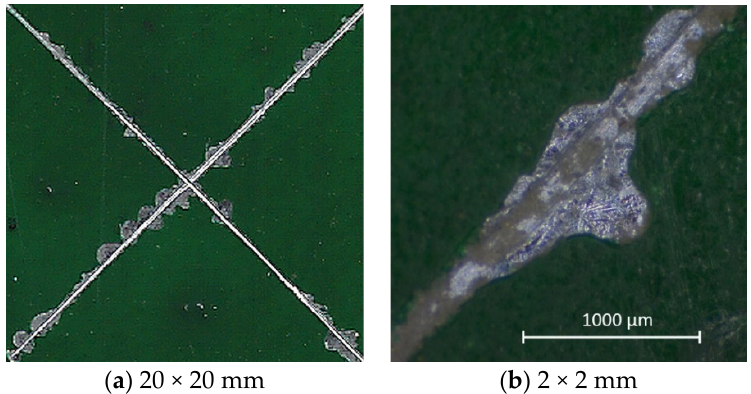
Figure 7. Destruction of the zinc layer under bacterial colonies after 8 weeks of exposition, ( a ) overview, ( b ) macroscopic image.